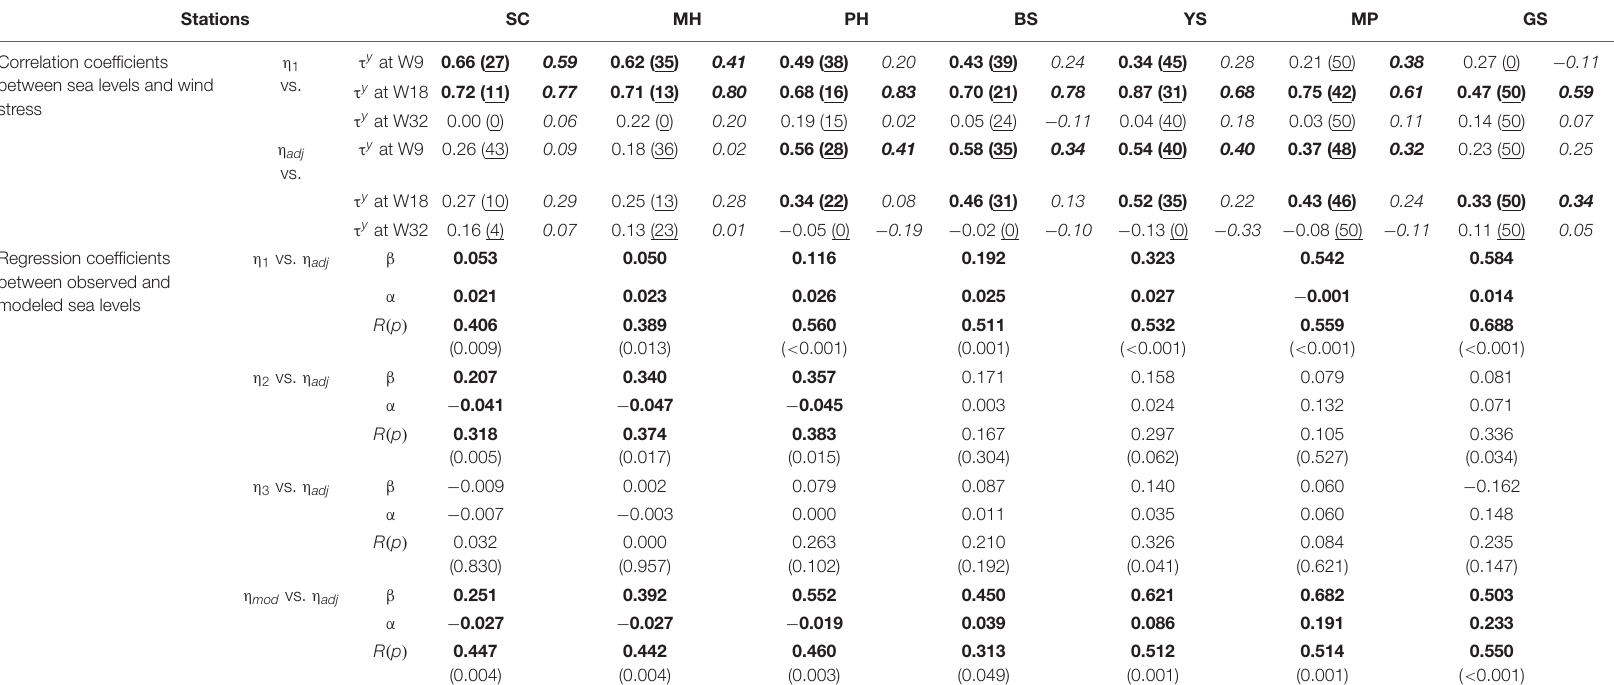
TABLE 3 | Cross-correlation coefficients (Left: CMEMS satellite wind, Right in italics: MERRA2 reanalysis wind) between τ y at three wind grids ( τ y at W9, W18, and W32) and η 1 , and between τ y at three wind grids and η adj at each TG station from September 1 to October 30,